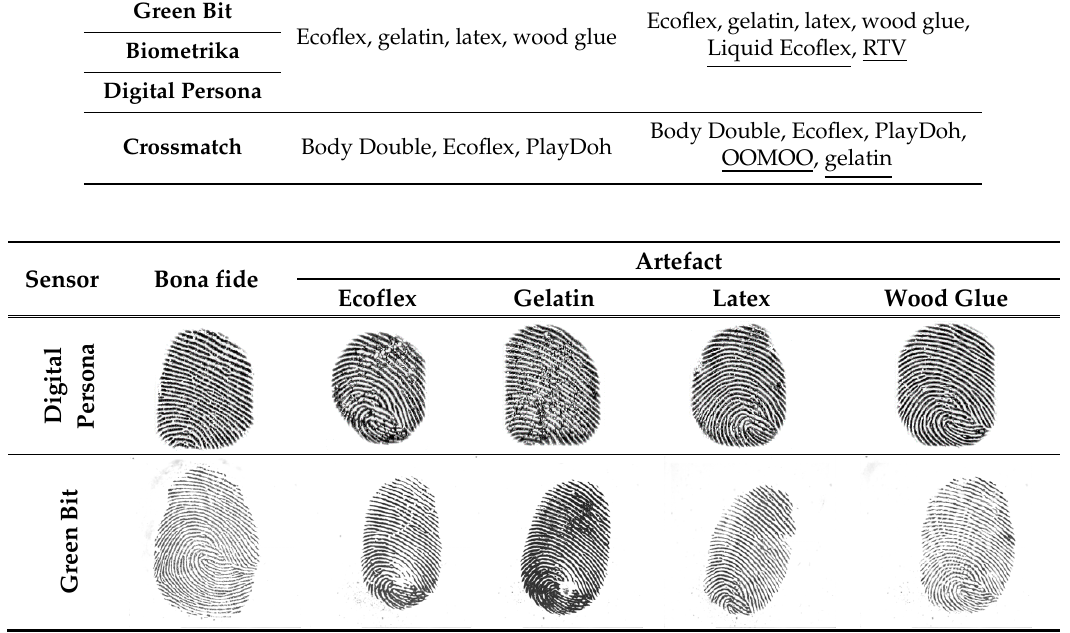
Table 2. Materials used for fabricating fake images in the LivDet 2015 dataset. Some materials in the testing are unknown during training (underlined).